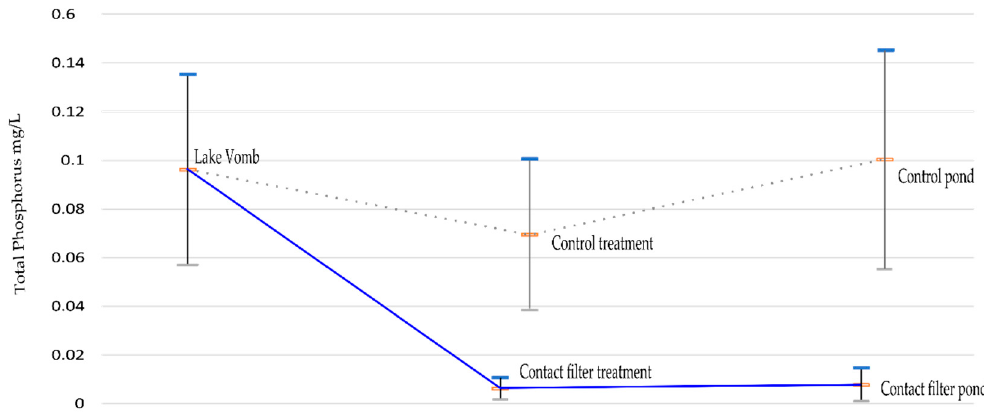
Figure 5. Total phosphorus removal at different stages along the two treatment processes. The middle bar is the mean value and the top and lower bars show the standard deviation. The dotted line is the contact filter treatment process and the solid line is the control treatment process.